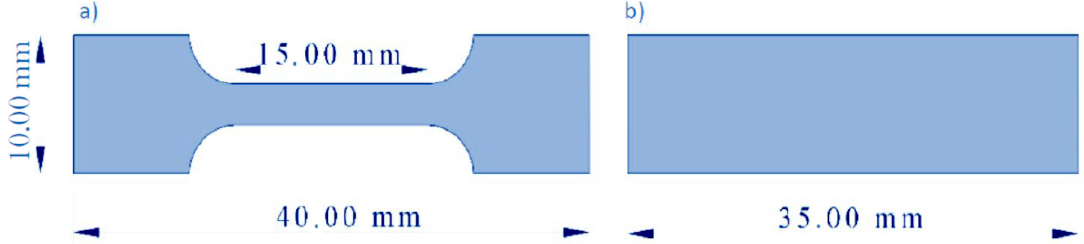
Figure 6. Dimensioned CAD model of solid specimens for strength tests: ( a ) tensile; ( b ) on bending. The characteristic quantities, namely, tensile strength (cid:1844) (cid:3040) , yield strength (cid:1844) (cid:3032) and bending